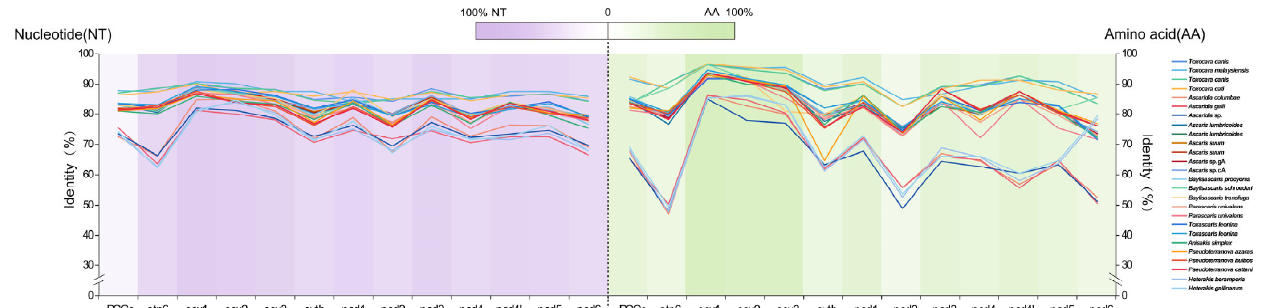
Figure 5. Pair-wise comparison of the nucleotide ( left ) and amino acid ( right ) sequence identities for PCGs. Colors from purple (high identity) to white (low identity) indicate the different identities of nucleotide sequences, and colors from green (high identity) to white (low identity) indicate the different identities of amino acid sequences.